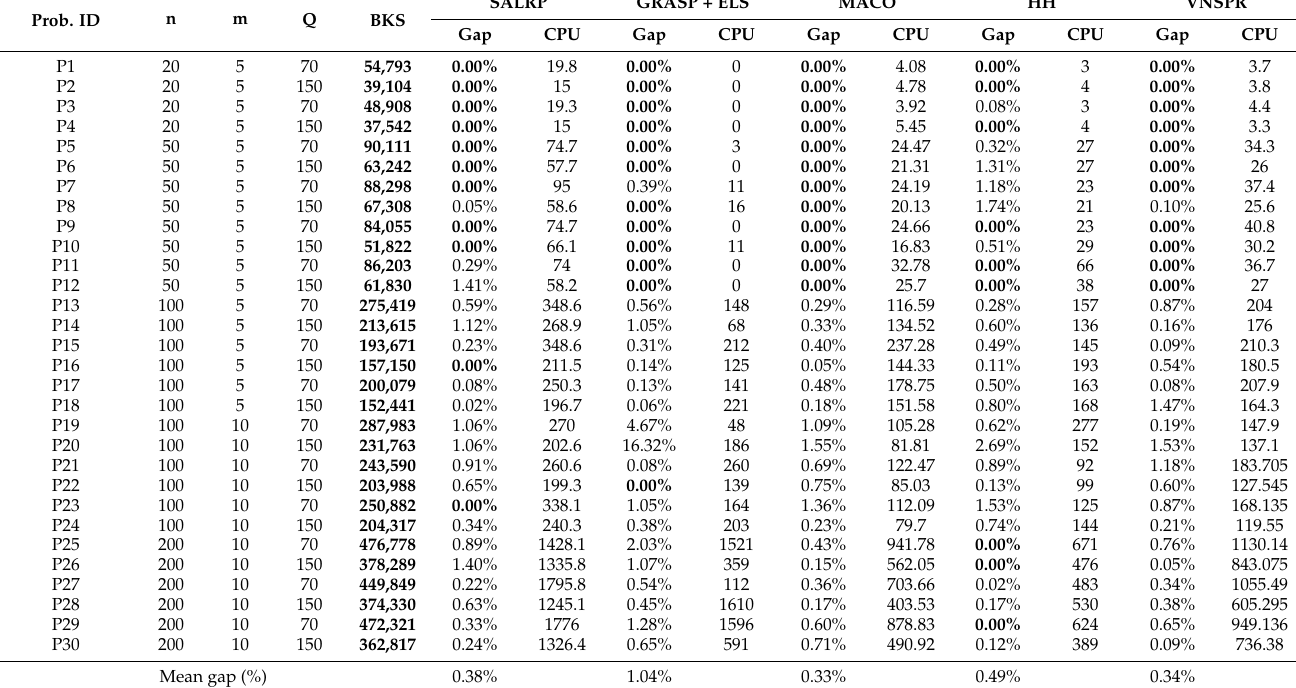
Table 3. Results of CLRP for the Prins et al.’s [40]